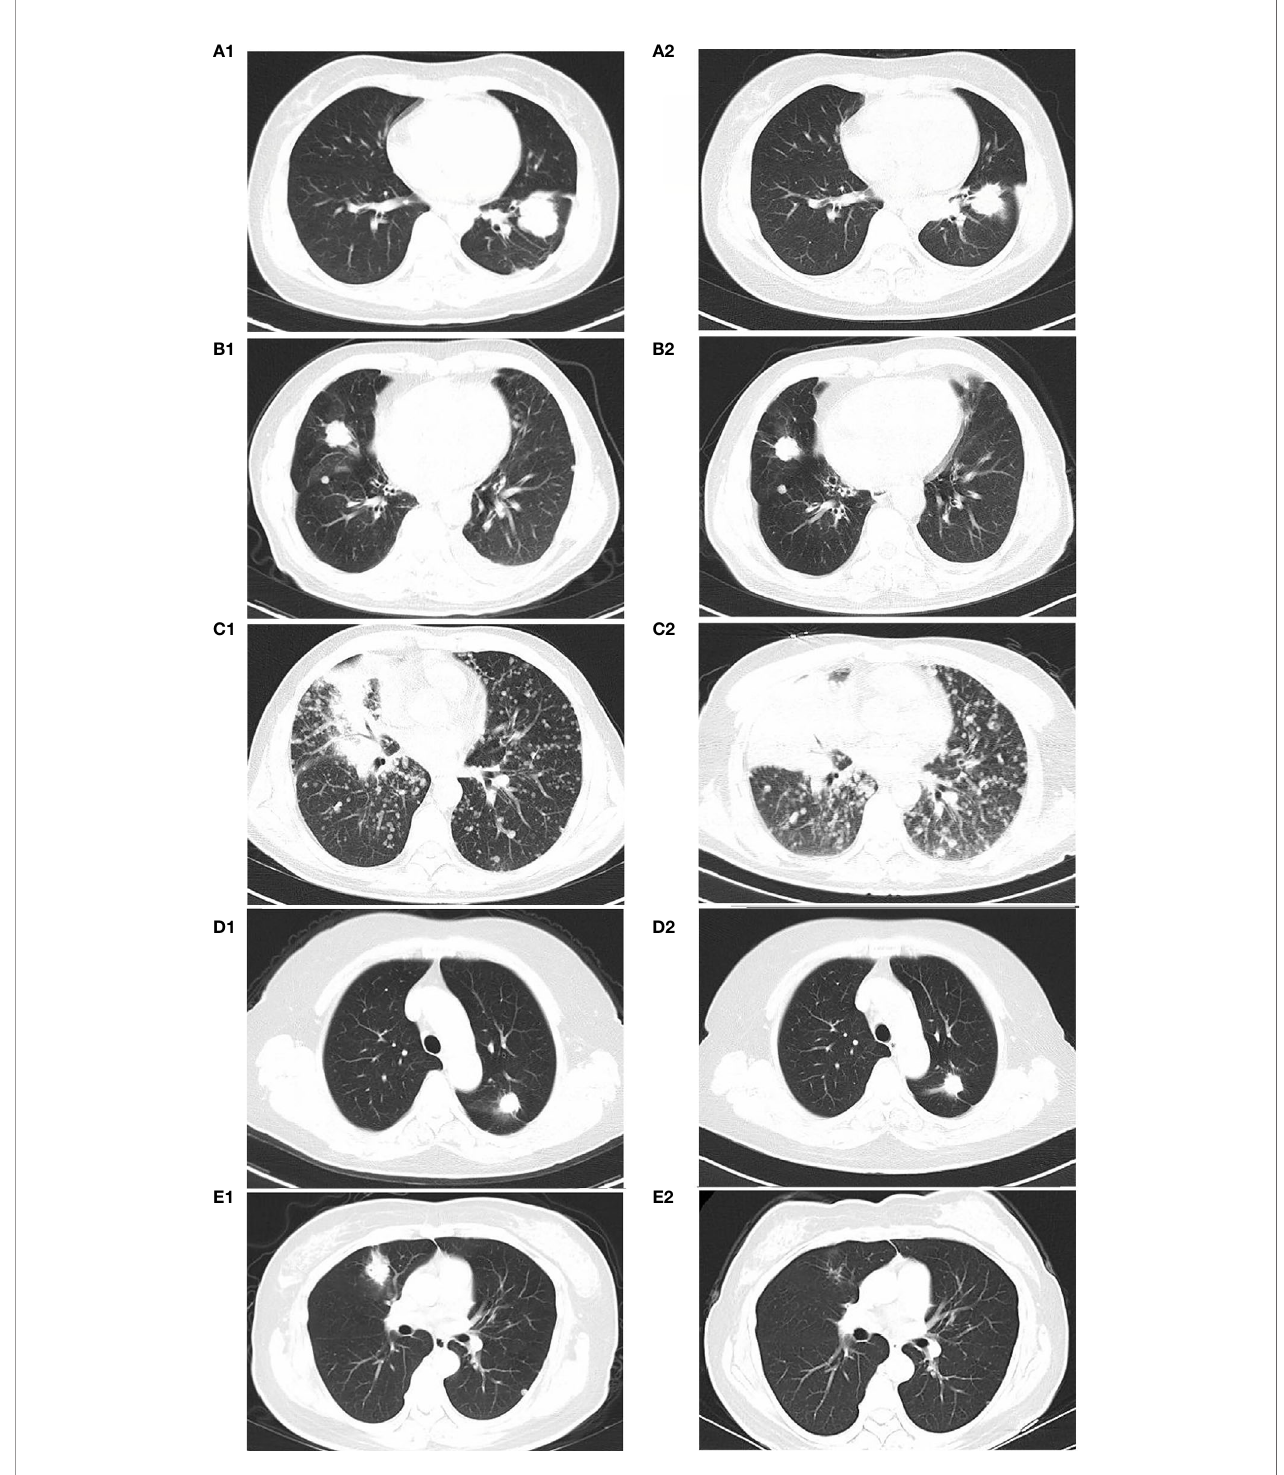
FIGURE 1 | CT imaging of best disease response of patients: Case 1 at beginning of therapy (A1) and 4 months after receiving carboplatin+pemetrexed chemotherapy and sintilimab (A2) Case 2 at beginning of therapy (B1) and 5 months after receiving carboplatin+pemetrexed chemotherapy and sintilimab (B2) Case 3 at beginning of therapy (C1) and 2 months after receiving carboplatin+pemetrexed chemotherapy and pembrolizumab (C2) Case 4 at beginning of therapy (D1) and 10 months after receiving carboplatin+pemetrexed chemotherapy and pembrolizumab (D2) Case 5 at beginning of therapy (E1) and 6 months after treatment with carboplatin, pemetrexed, and pembrolizumab for 4 cycles followed by pembrolizumab maintenance (E2)